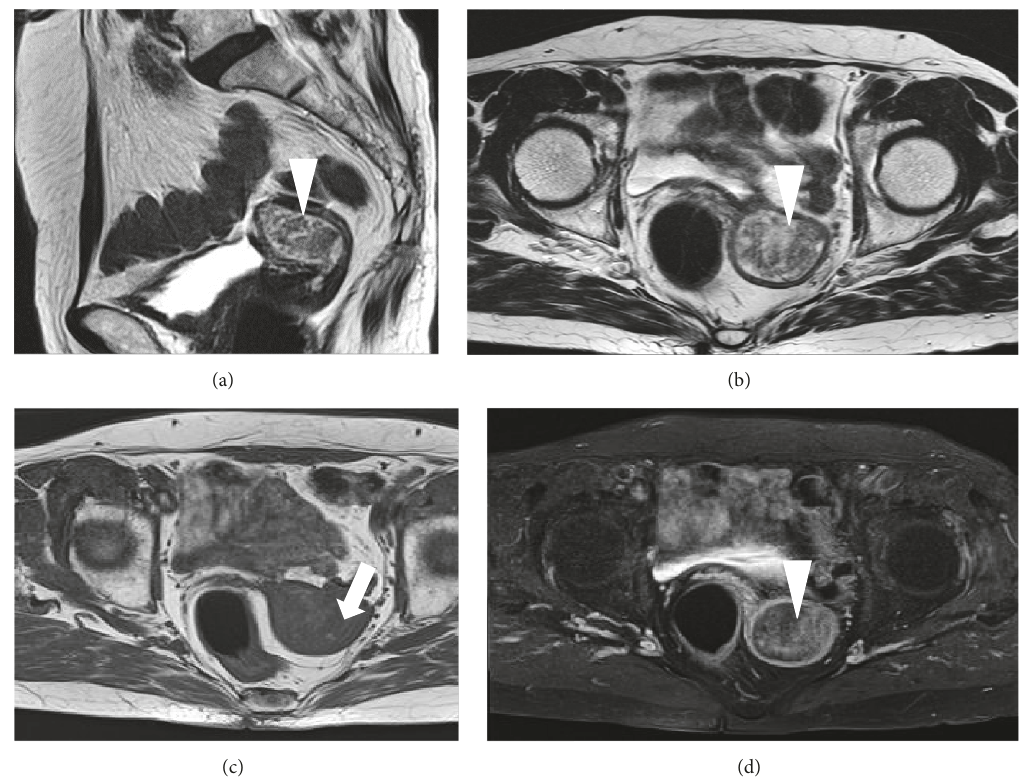
Figure 2: Magnetic resonance imaging of this patient . (a) Sagittal T2-weighted images (T2WI), showing an intrauterine tumor (triangle), which exhibited punctate heterogeneous hyperintensity or islands of isointense-to-hypointense signals. (b) View of the tumor (triangle) on axial T2WI. (c) Axial T1-weighted images (T1WI), showing that the tumor was detected as a hypointense signal with focal areas of high signal intensity (arrow), suspected of being hemorrhagic foci. (d) Axial contrast-enhanced T1WI showing a little tumor enhancement (triangle).